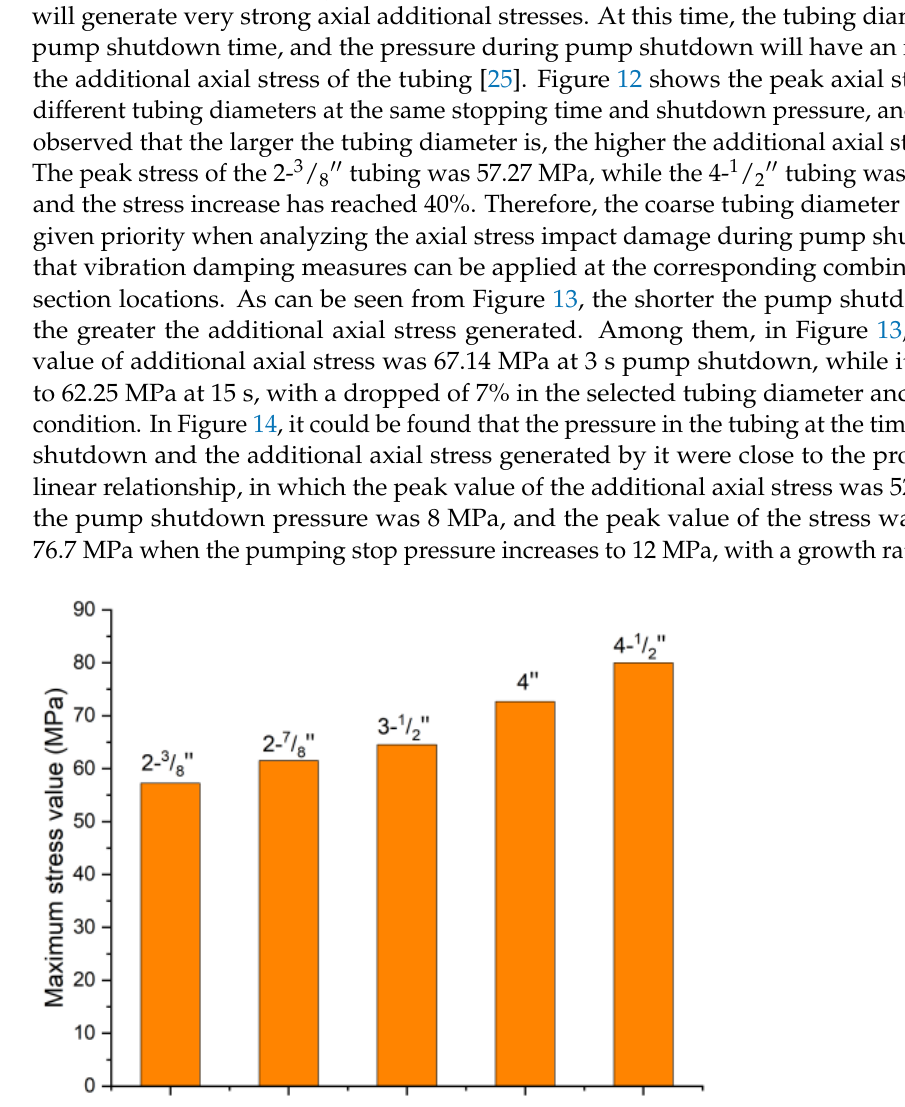
Figure 12. Maximum value of additional axial stress for different tubing diameters. (Uniform pump shutdown time of 6 s and inside pressure of 10 MPa).